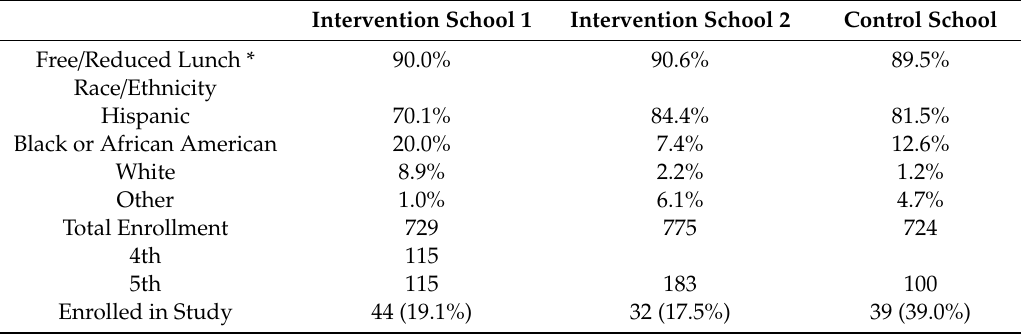
Table 1. School Demographics and Study Participants.